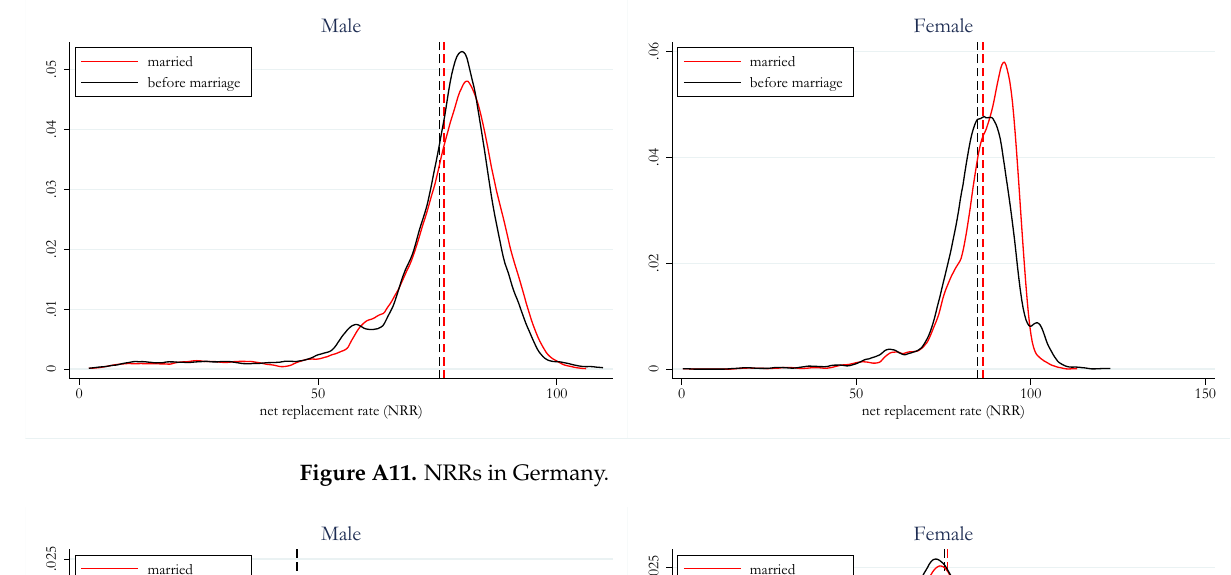
Figure A11. NRRs in Germany.